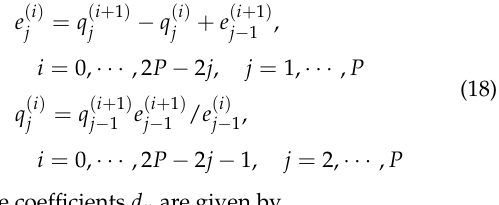
Fig. 4. Rail mesh generation and skin